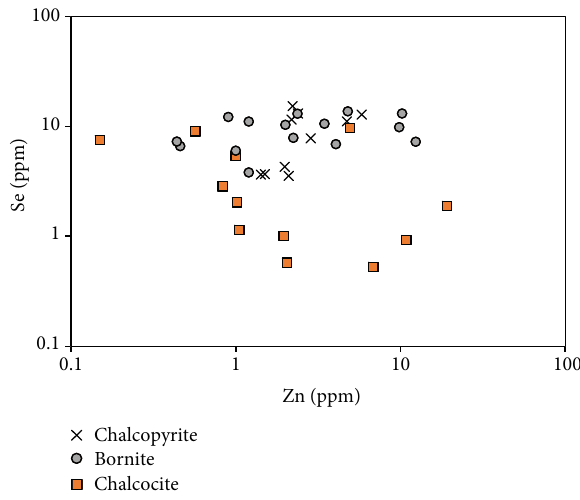
Figure 7: Plots showing Zn and Se variation in coexisting Cu-(Fe)- sul fi des in the 109 porphyry Cu